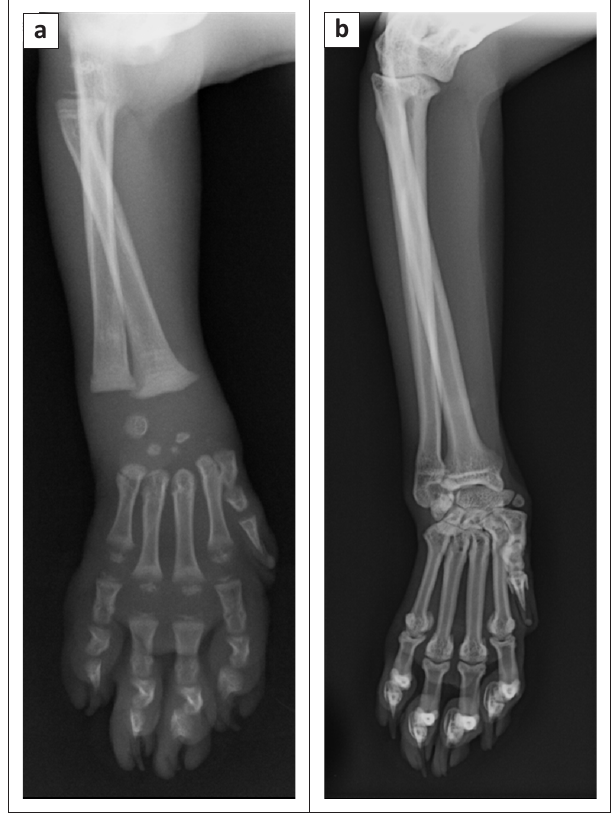
(a) The proximal epiphysis of the radius was poorly ossified whilst the distal epiphysis of the metacarpi and proximal epiphyses of the first phalanges were poorly developed. The distal radial and ulnar epiphyses were not visible. The carpal bones were poorly ossified (Settings: 44 kV, 5 mAs; no grid). (b) All physes of the radius and ulna were closed and all carpal bones were fully ossified (Settings: 44 kV, 5 mAs; no grid). FIGURE 3: (a) Craniocaudal view of the right antebrachium and manus at 3 months and (b) craniocaudal view of the right antebrachium and manus at 26